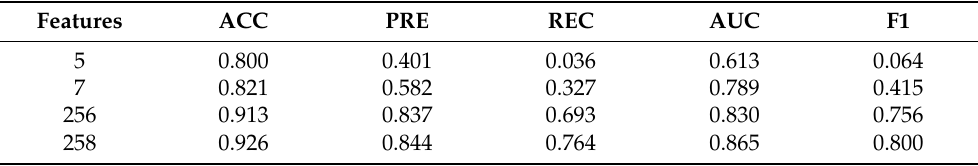
Table 3. Performance evaluation of adding metadata.